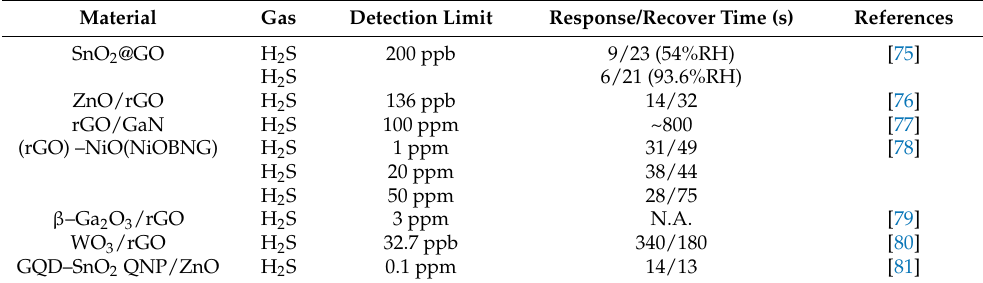
Table 3. The detection range and response/recovery time of graphene composites to H 2 S